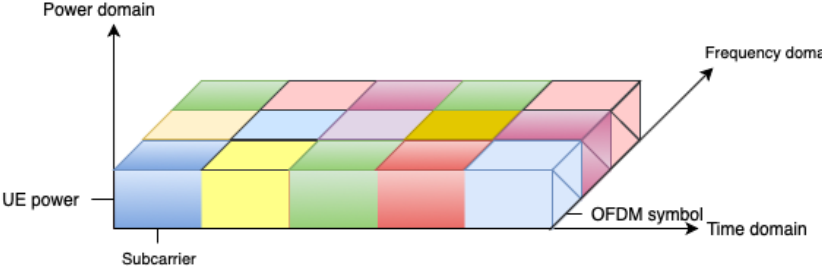
Figure 3. Resource allocation of OFDM technology.